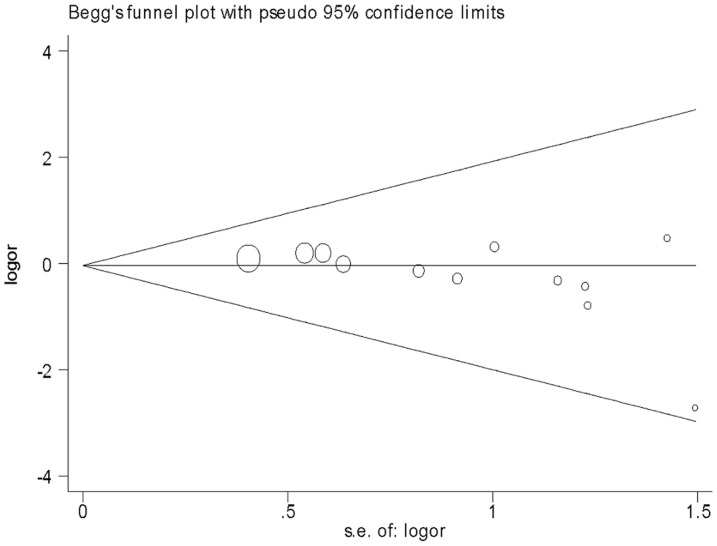
Funnel plot for publication bias in selection of studies on the CTLA-4 −318 C/T polymorphism (CC+CT vs. TT).